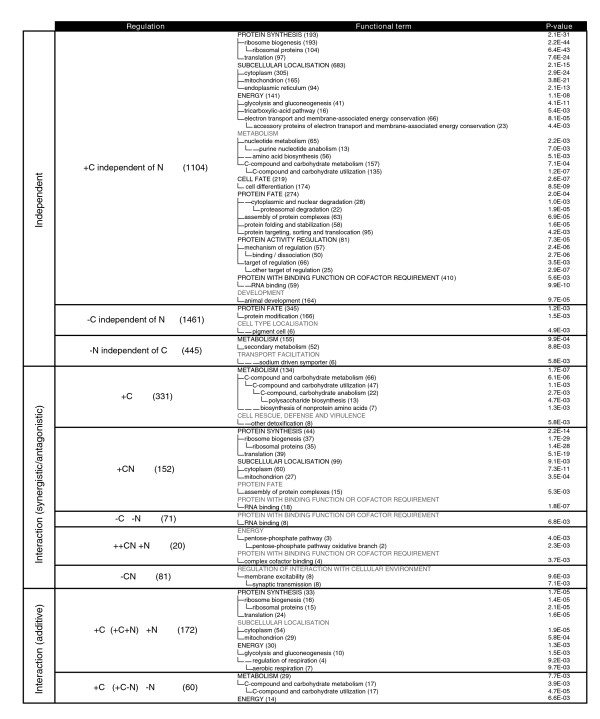
C, N and CN regulation of metabolism and other cellular processes. The number in parenthesis next to each MIPS functional term indicates the number of genes annotated to that term. Categories in gray are not significantly over-represented, but are provided to facilitate data interpretation. The 'Regulation' column shows patterns of regulation as described in Table 1.